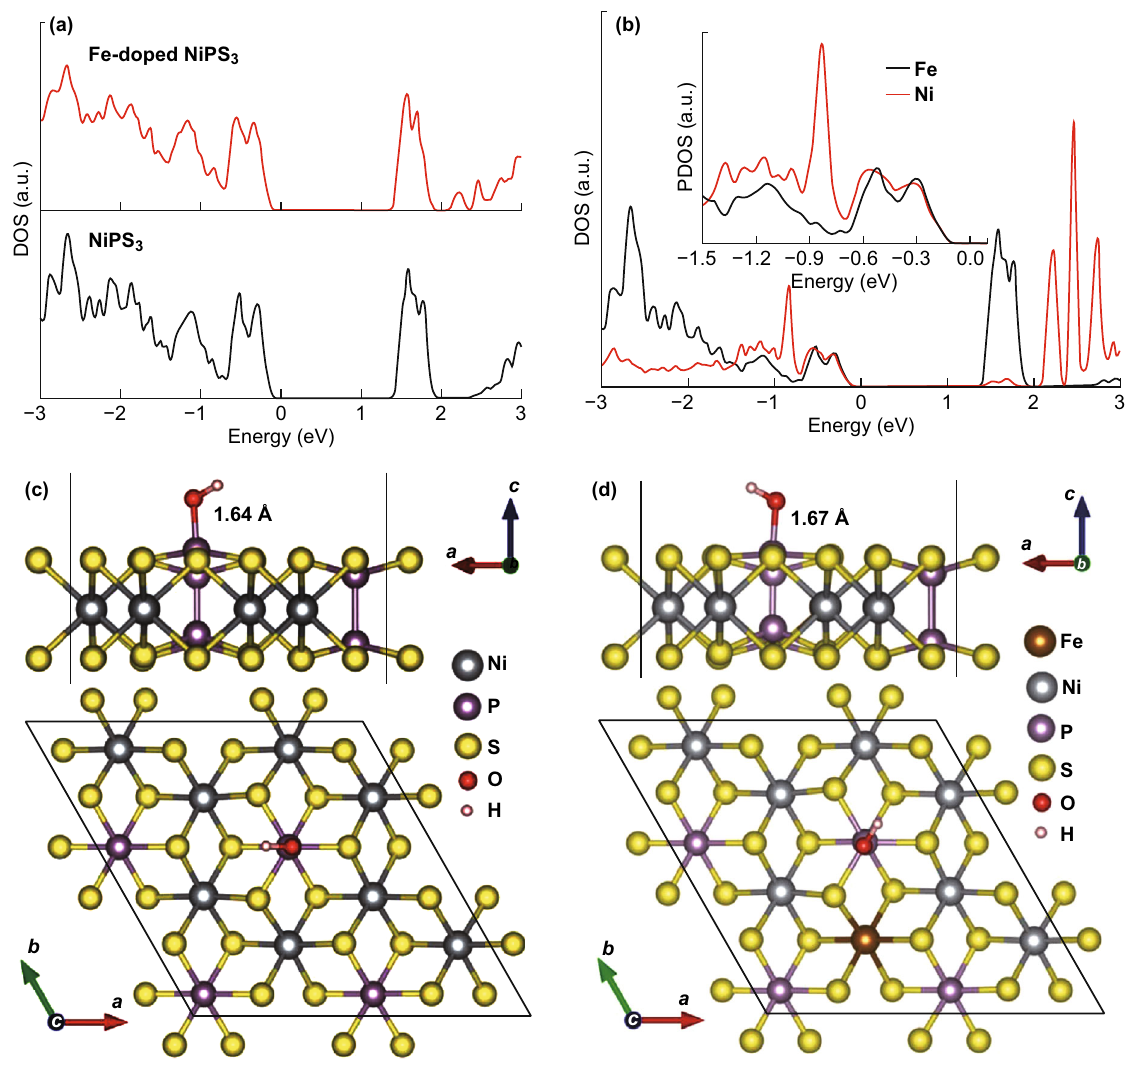
Fig. 6 a Calculated total DOS for NiPS 3 and Fe-doped NiPS 3 . b Projected DOS for Ni and Fe obtained from DFT ? U calculations for Fe- doped NiPS 3 . Optimized structures of c NiPS 3 and d Fe-doped NiPS 3 for calculating the free energies of adsorption of oxygen-containing intermediates on their surfaces by DFT calculations. The inset in b is the enlarged projected DOS near the Fermi level [80]. Reproduced